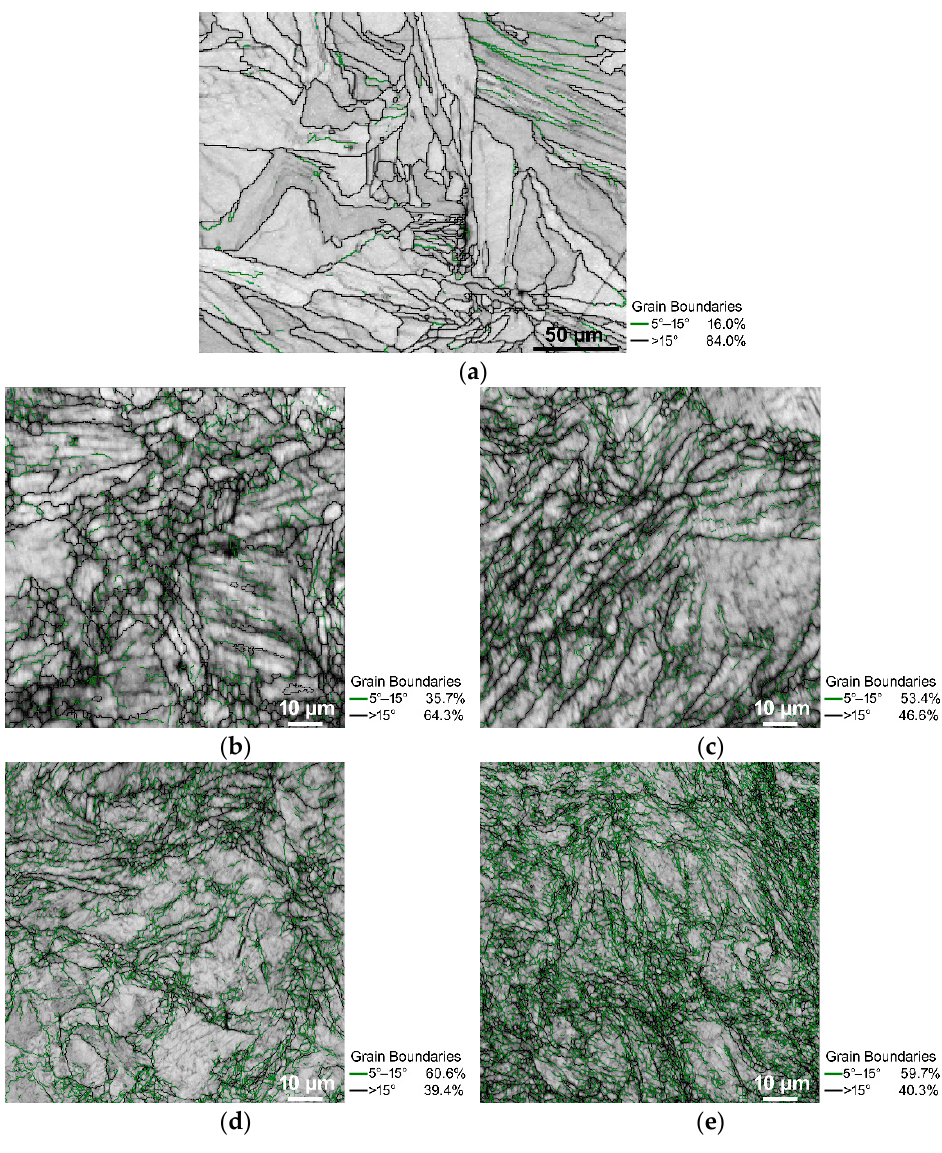
Figure 2. EBSD band contrast images with HAGBs depicted in black, and LAGBs depicted in green: SLM sample ( a ); sample 1 ( b ); sample 2 ( c ); sample 3 ( d ); sample 4 ( e ). SLM sample ( a ); sample 1 ( b ); sample 2 ( c ); sample 3 ( d ); sample 4 ( e